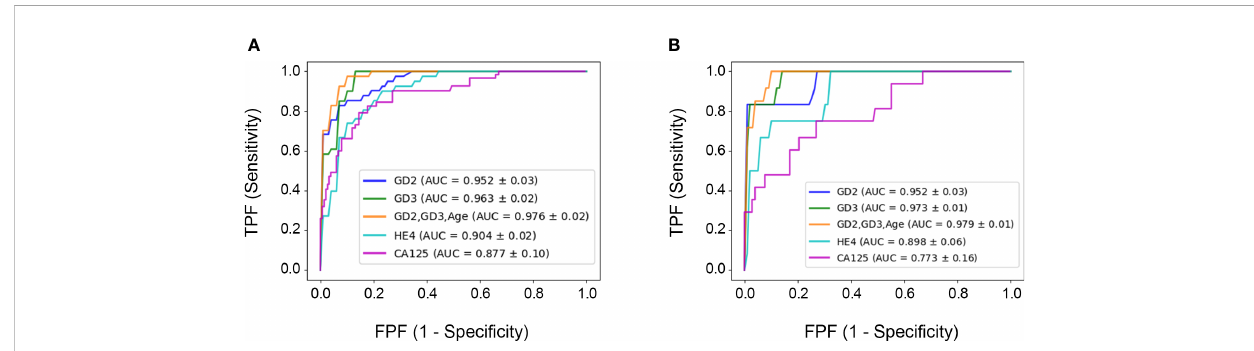
FIGURE 4 Receiver operator curves for each biomarker. (A) 5× cross-validation for the overall cohort. (B) 3× cross-validation for the segmented early-stage population. The ROC curve and diagnostic performance of GD2 and GD3 was done for all samples FIGO I – IV (n=41) or for segmented data FIGO stages I and II (n=14). The area under the curve (ROC – AUC) values for each test and the p-values of comparisons are listed in the caption and in Table